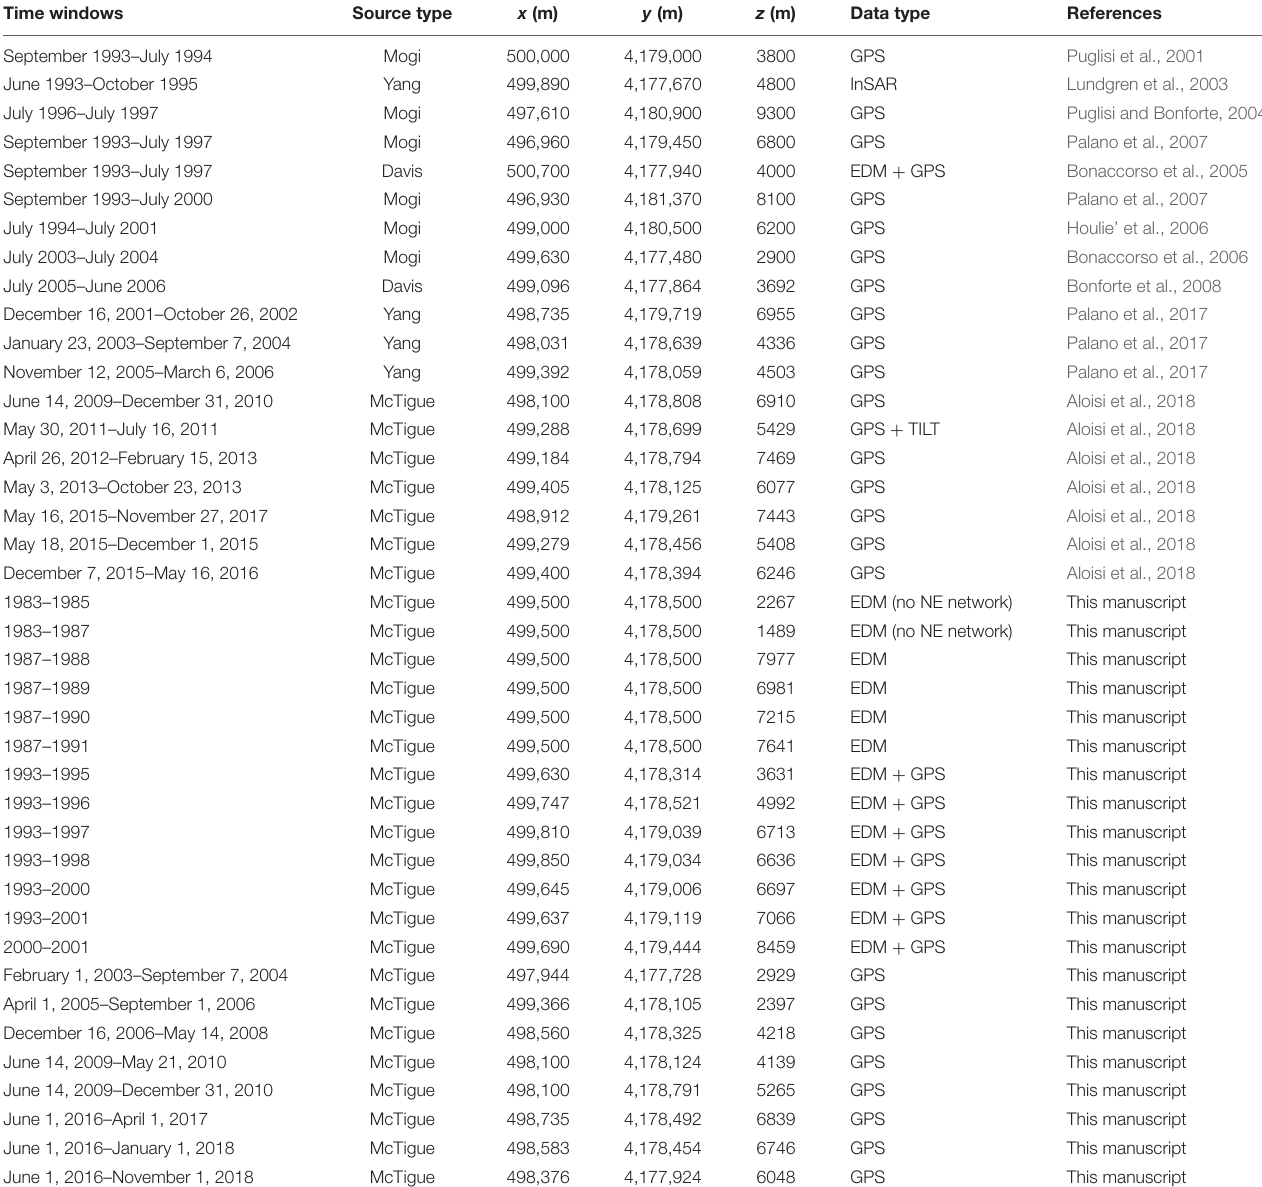
TABLE 4 | Summary table of inflation sources modeled from literature and this